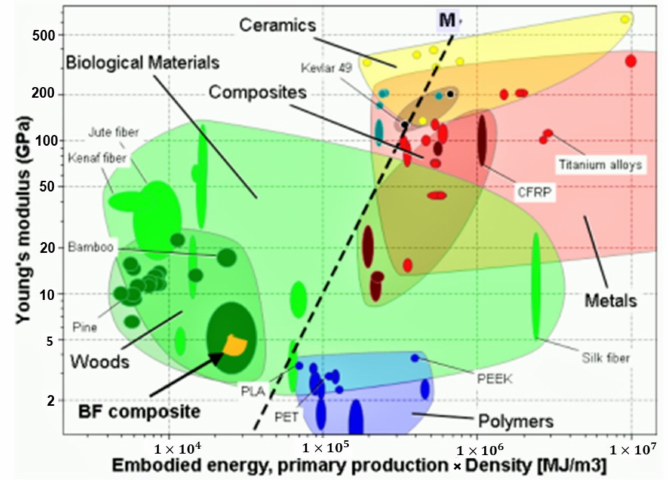
Figure 14. Selection chart for stiffness vs. embodied energy after screening of irrelevant materials. The superior materials are in the top left corner (high modulus for low embodied